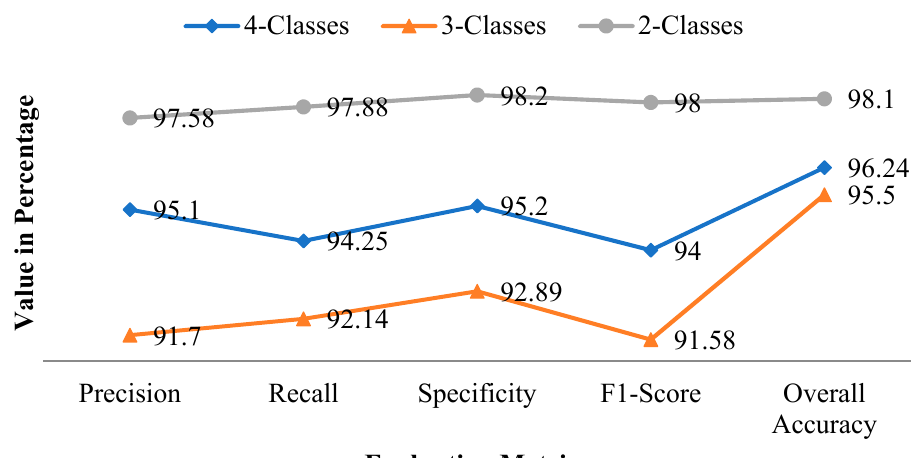
Figure 8. Metrics graph of all three classes.